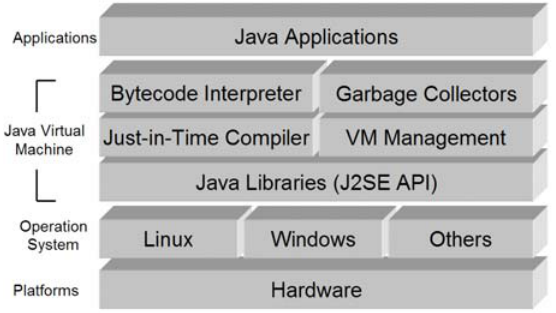
Figure 4. The structure of Java virtual machines